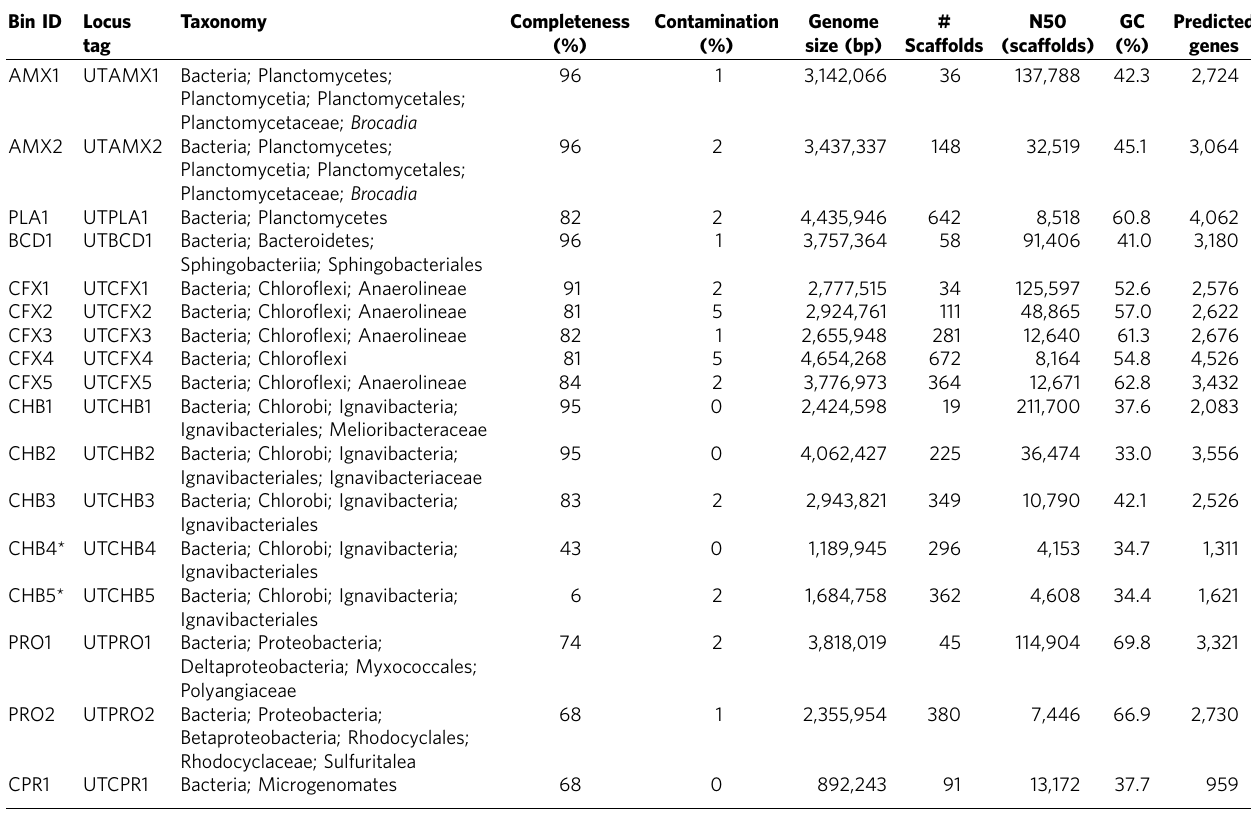
Table 1 | Genome statistics of MAGs recovered from the anammox community. Bin ID Locus tag